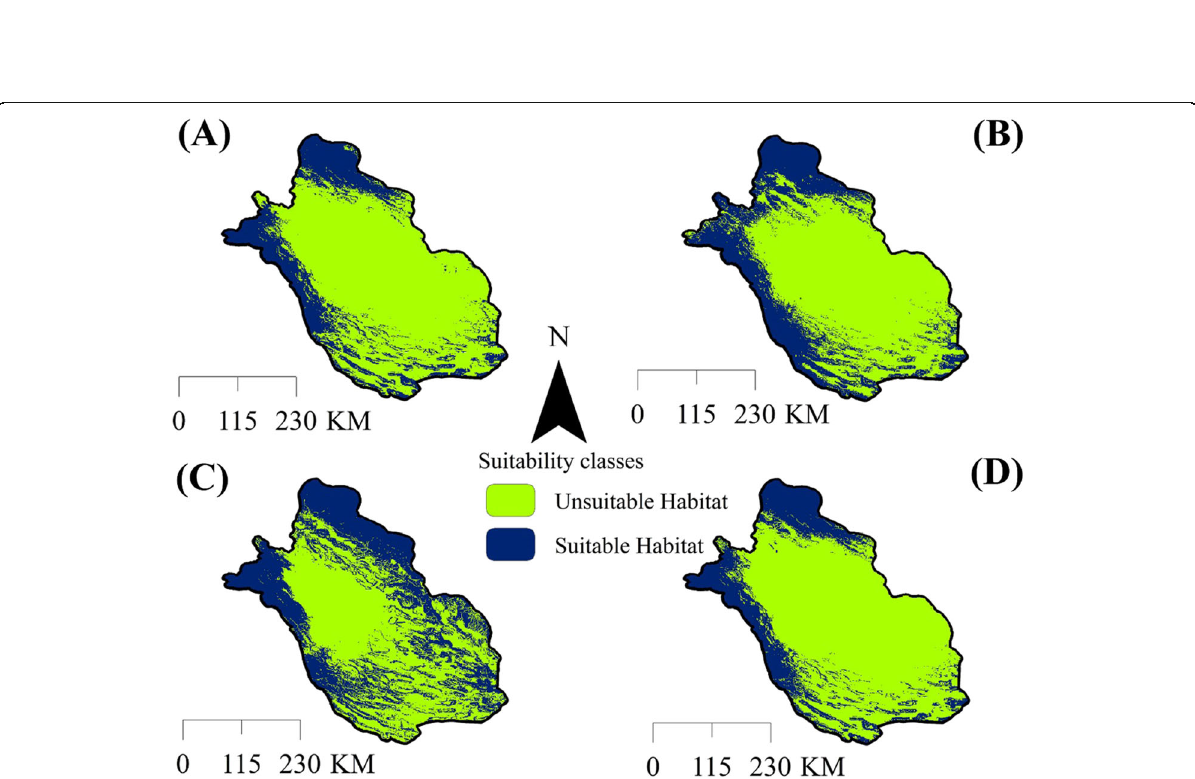
Fig. 4 Discrete habitat suitability map of Amygdalus scoparia after applying optimal threshold limits in Fars Province. a BP-ANN, b GLM; c MaxEnt, and d ensemble